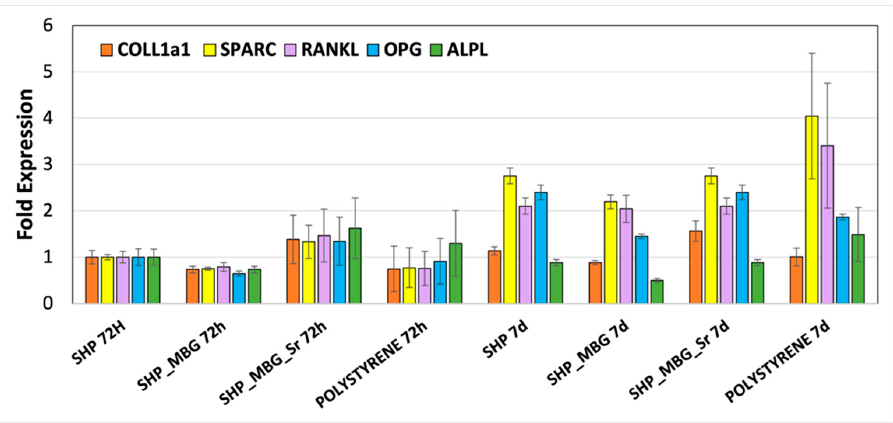
Figure 6. Gene expression of SAOS2 osteoblast-like cells at 72 h and 7 days of culture with SHP, SHP_MBG and SHP_MBG_Sr. Polystyrene was also tested as a control condition.